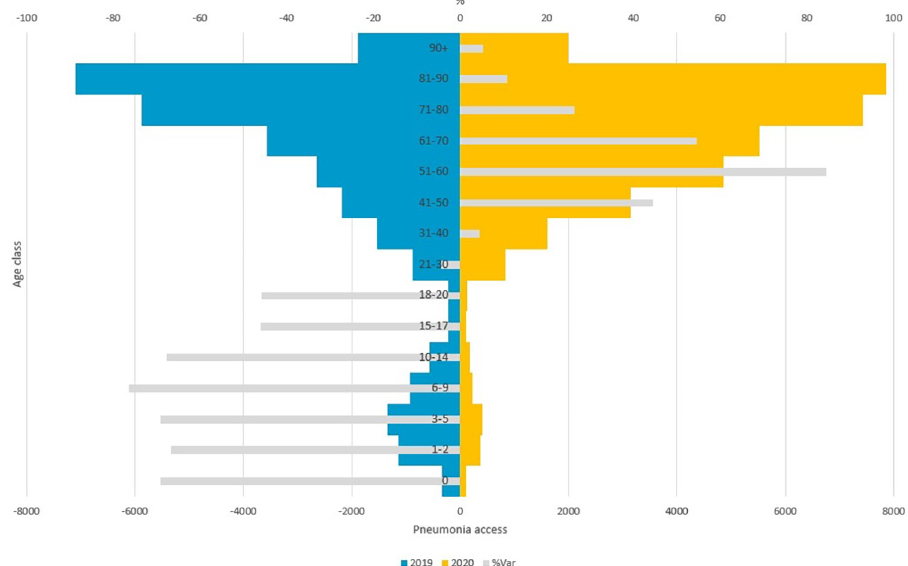
Fig 3. ED access for suspected COVID-19 pneumonia, by age class and year (2019, 2020). The blue bars refer to ED accesses for suspected COVID-19 pneumonia in 2019, the yellow bars refer to for suspected COVID-19 pneumonia in 2020 and the grey bars indicate the percent variation of ED accesses for pneumonia in 2020 and 2019.